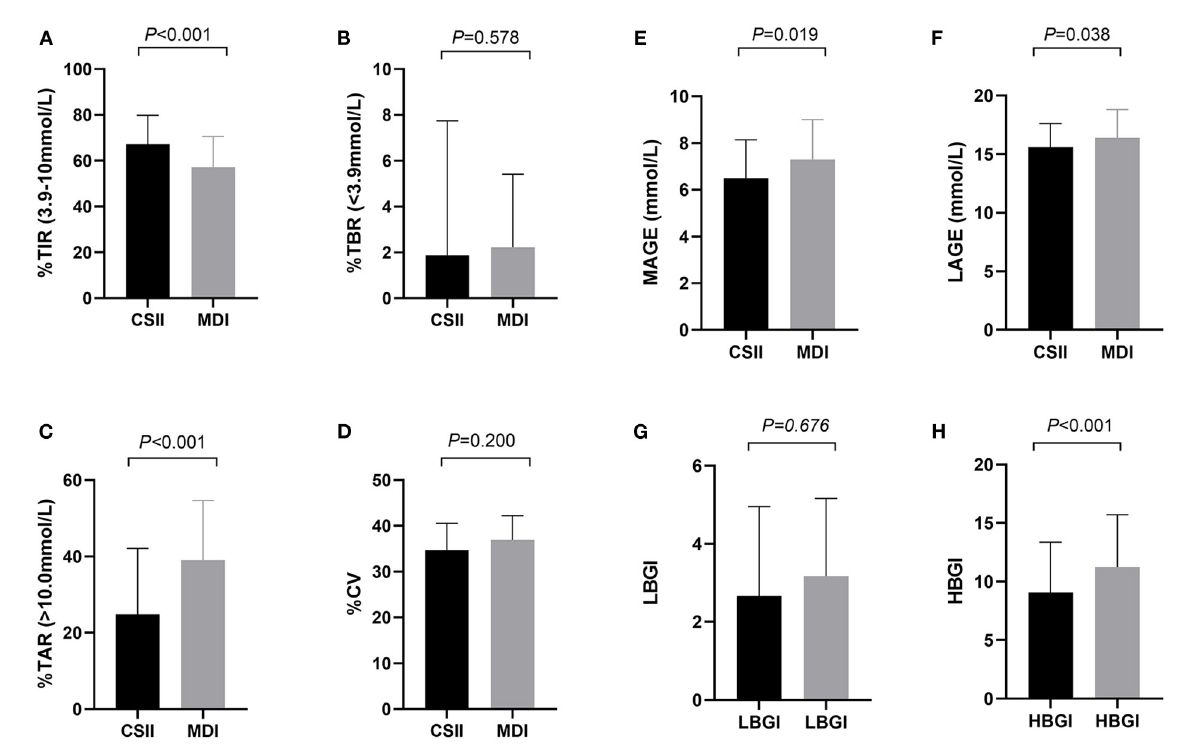
FIGURE1 CGM-derived metrics of patients in CSII group and MDI group ( n = 362). (A) TIR, (B) TAR, (C) TBR, (D) CV, (E) MAGE, (F) LAGE, (G) LBGI, (H) HBGI. Abbreviations: CGM, continuous glucose monitoring; MDI, multiple daily insulin injection; CSII, continuous subcutaneous insulin infusion; TIR, time in range; TAR, time above range; TBR, time below range; CV, coefficient of variation; MAGE, mean amplitude of glucose excursions; LAGE, mean amplitude of glucose excursions; LBGI, low blood glucose index; HBGI, high blood glucose index. Data are shown as median (IQR). P values for CSII group vs. MDI